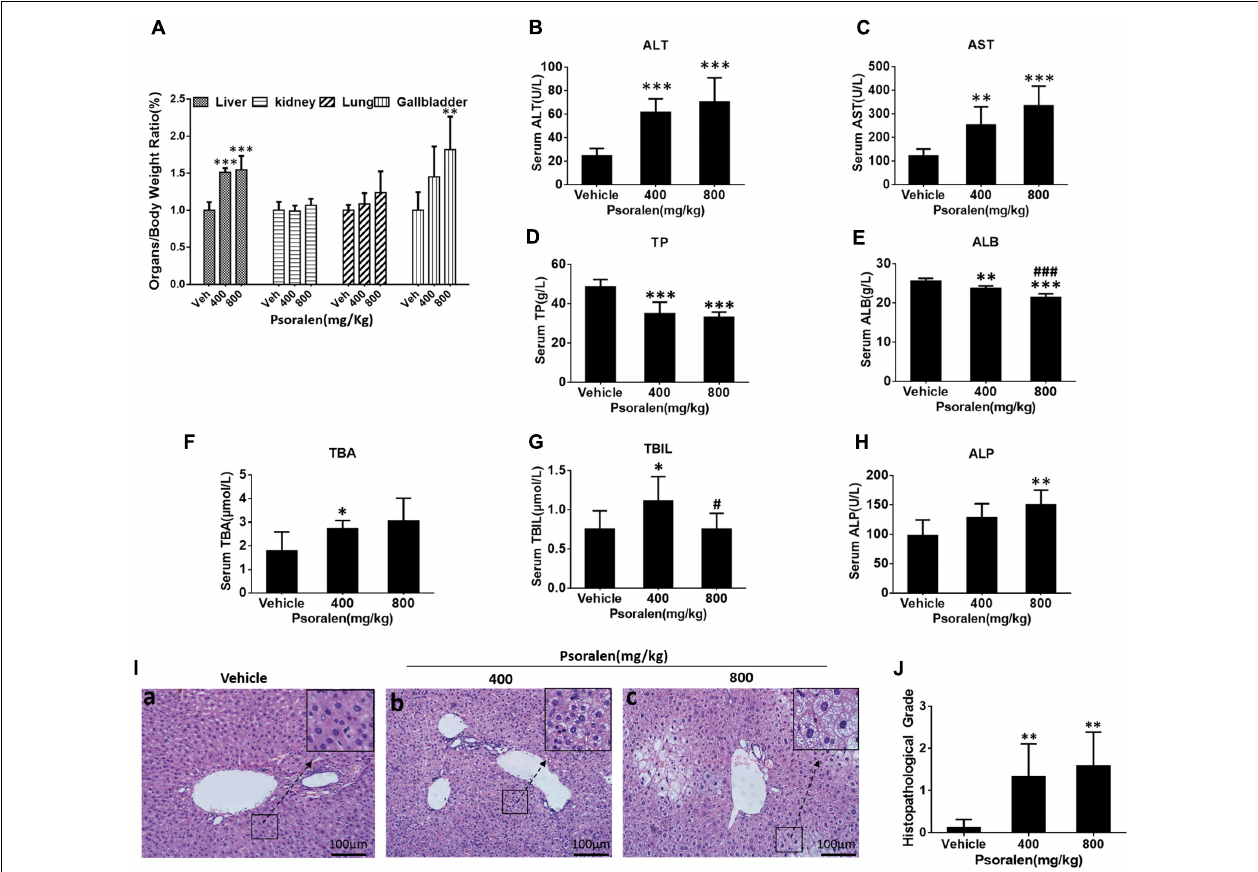
FIGURE 1 | Treatment with psoralen induced liver injury in vivo . C57BL/6 mice were treated with 0.5% CMC-Na solution (vehicle group), 400 mg/kg, or 800 mg/kg of psoralen for 24 h. (A) Several organ-to-body weight ratios. (B) Serum ALT, (C) AST, (D) TP, (E) ALB, (F) TBA, (G) TBIL, (H) ALP levels. (I) Liver sections were stained with haematoxylin and eosin (HE), the representative micrographs of vehicle, 400 mg/kg, and 800 mg/kg psoralen groups are shown in (a–c), respectively; original magnification, 200 × . (J) The overall degree of liver injury in each group was expressed as histopathological grade. Values are means ± SDs ( n =